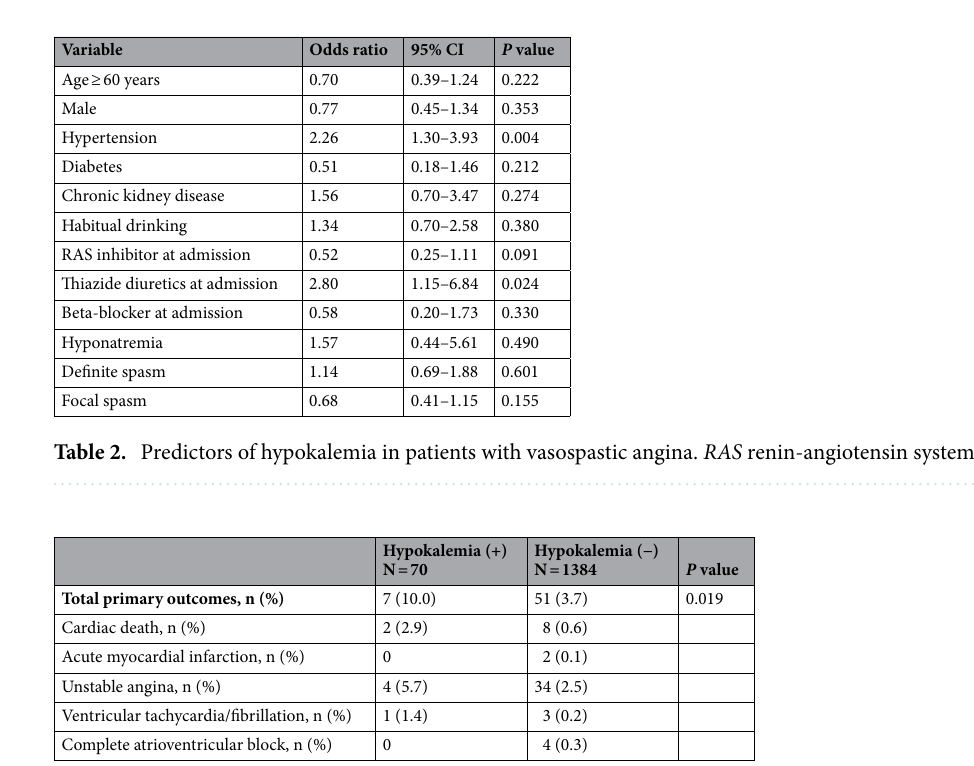
Table 3. Incidence of primary outcomes in patients with vasospastic